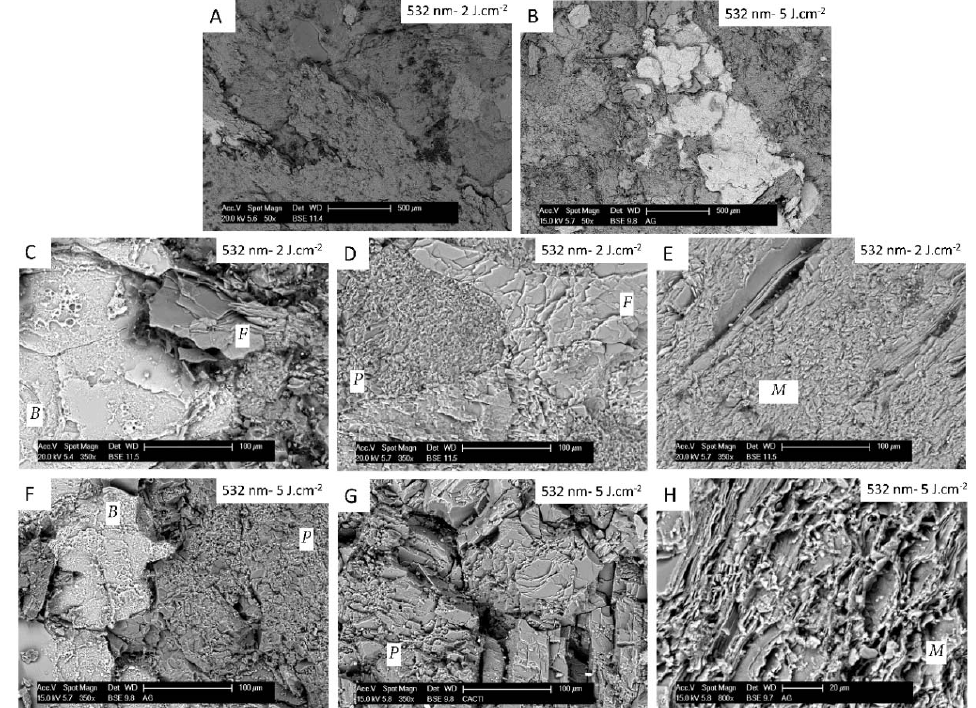
Figure 7. SEM micrographs of the treated surfaces with an Nd:YAG laser working at 532 nm at two different fluences (2 and 5 J ∙ cm − 2 ). B: biotite, P: plagioclase, F: feldspar, M: muscovite.